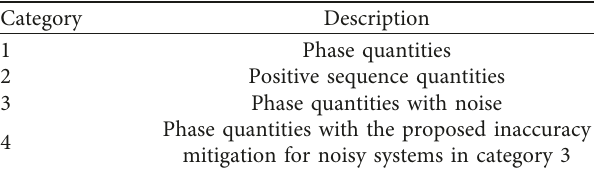
Table 2: The four categories for this study.